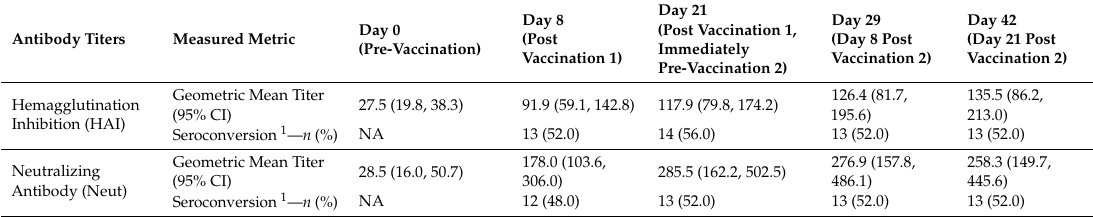
Figure 1. Reverse cumulative distribution curves of serum hemagglutination inhibition and neutralizing antibodies following immunization with H3N2v vaccine. Table 2. Serum Hemagglutination Inhibition and Neutralizing antibody levels and percent of subjects seroconverting after the first and second doses of H3N2v